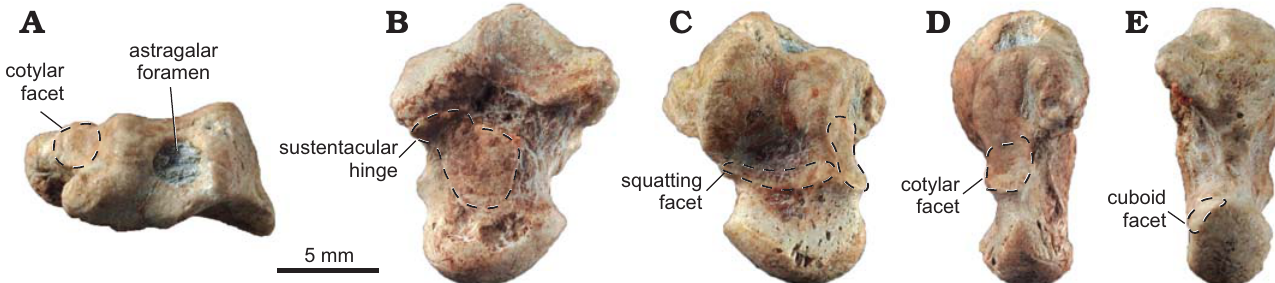
Fig. 2. Hilalia saribeya Maas, Thewissen, Sen, Kazanci, and Kappelman, 2001 from the middle Eocene Uzunçar ş ı dere Formation, Central Turkey; right as- tragalus (EOU-UCF-1) in proximal ( A ), plantar ( B ), dorsal ( C ), medial ( D ), and lateral ( E ) views. Each homologous articular facet is marked by dashed line.